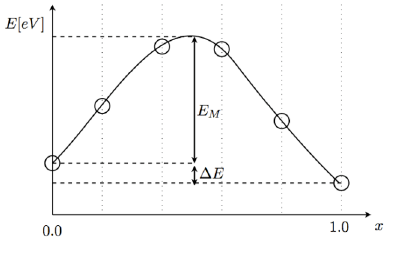
Fig. 4. Vacancy Migration Energy (VME). x is the dimensionless advancement coordinate along the atom displacement path. The y-axis of the figure is the total energy of the system in electron volts. E M is a cubic spline interpolation of the saddle point in the minimum energy path found by the drag